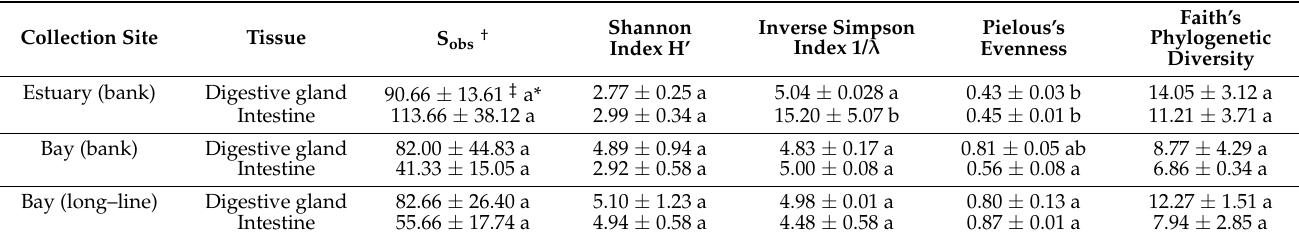
Table 3. Alpha diversity among bacterial communities in digestive gland and intestine tissues of Choromytilus chorus grown in estuary water (Nehuentue) and bay seawater (Hueihue).